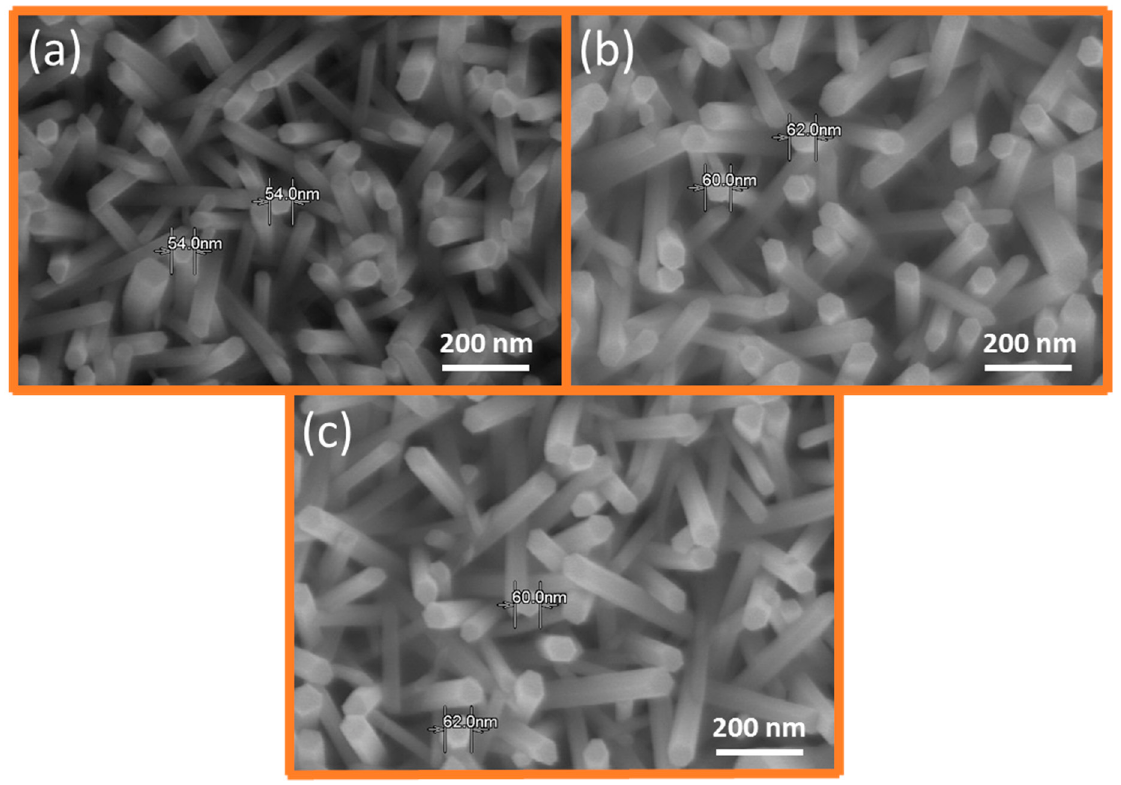
Figure 3. SEM images of: ( a ) 1%; ( b ) 2%; and ( c ) 5% GZRs grown with NH 4 OH treatment.